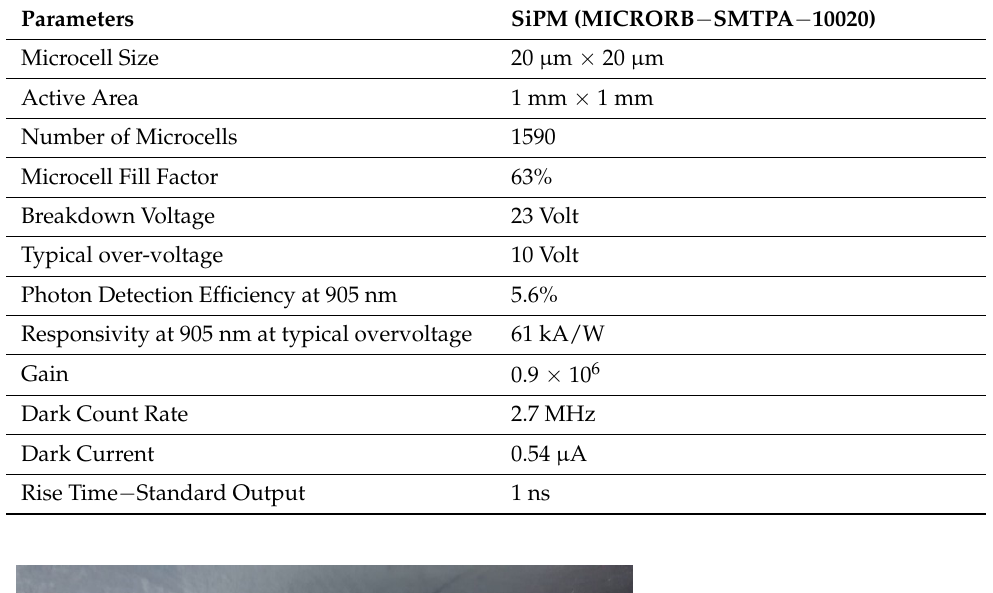
Table 1. SiPM parameters from the reference [35].